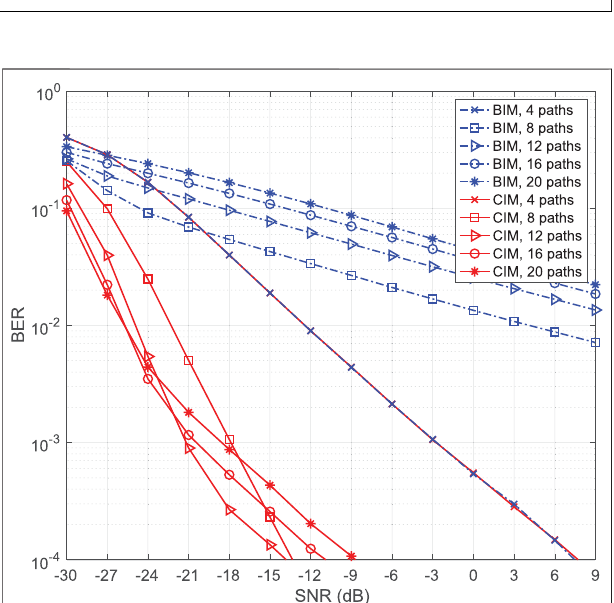
FIGURE 5 | Distribution fi t for variables X and Y.